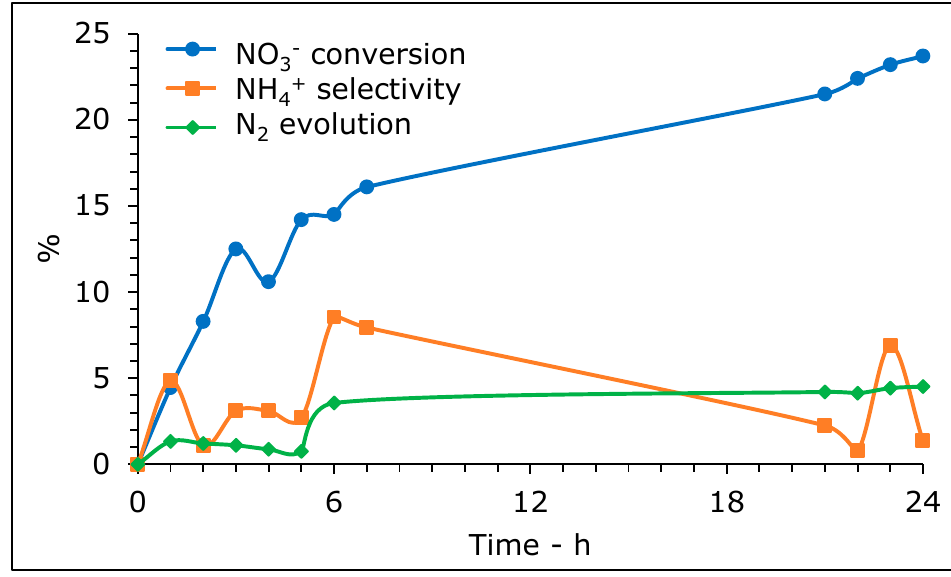
Figure 4. Photo-reduction of NO 3 − under UV irradiation (Irradiance = 260 W/m 2 ) with 0.1% Pt/FSP as photocatalyst (1 g/L), NaNO 3 (6 mM), pH 5, rt and 250 mL of solution (Reactor 1).